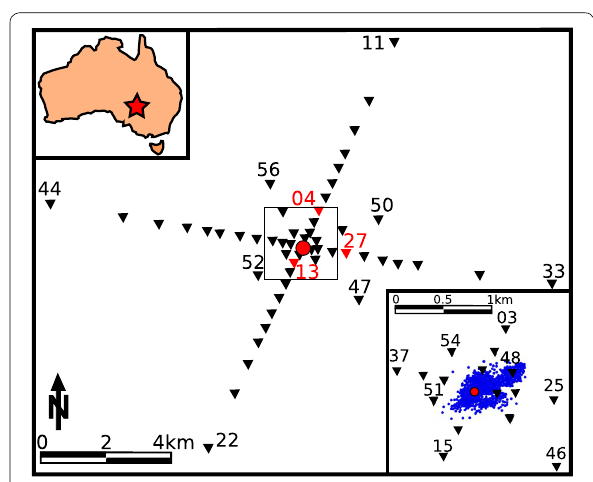
Fig. 10 Survey layout for the Paralana MT monitoring experiment [adapted from Peacock et al. (2013)]. The black triangles are the MT stations and the red triangles represent the stations used in our study. The red circle represents the Paralana 2 wellbore. The rectangle surrounding Paralana 2 is inflated in the bottom right, with the micro- seismic events shown as small blue circles